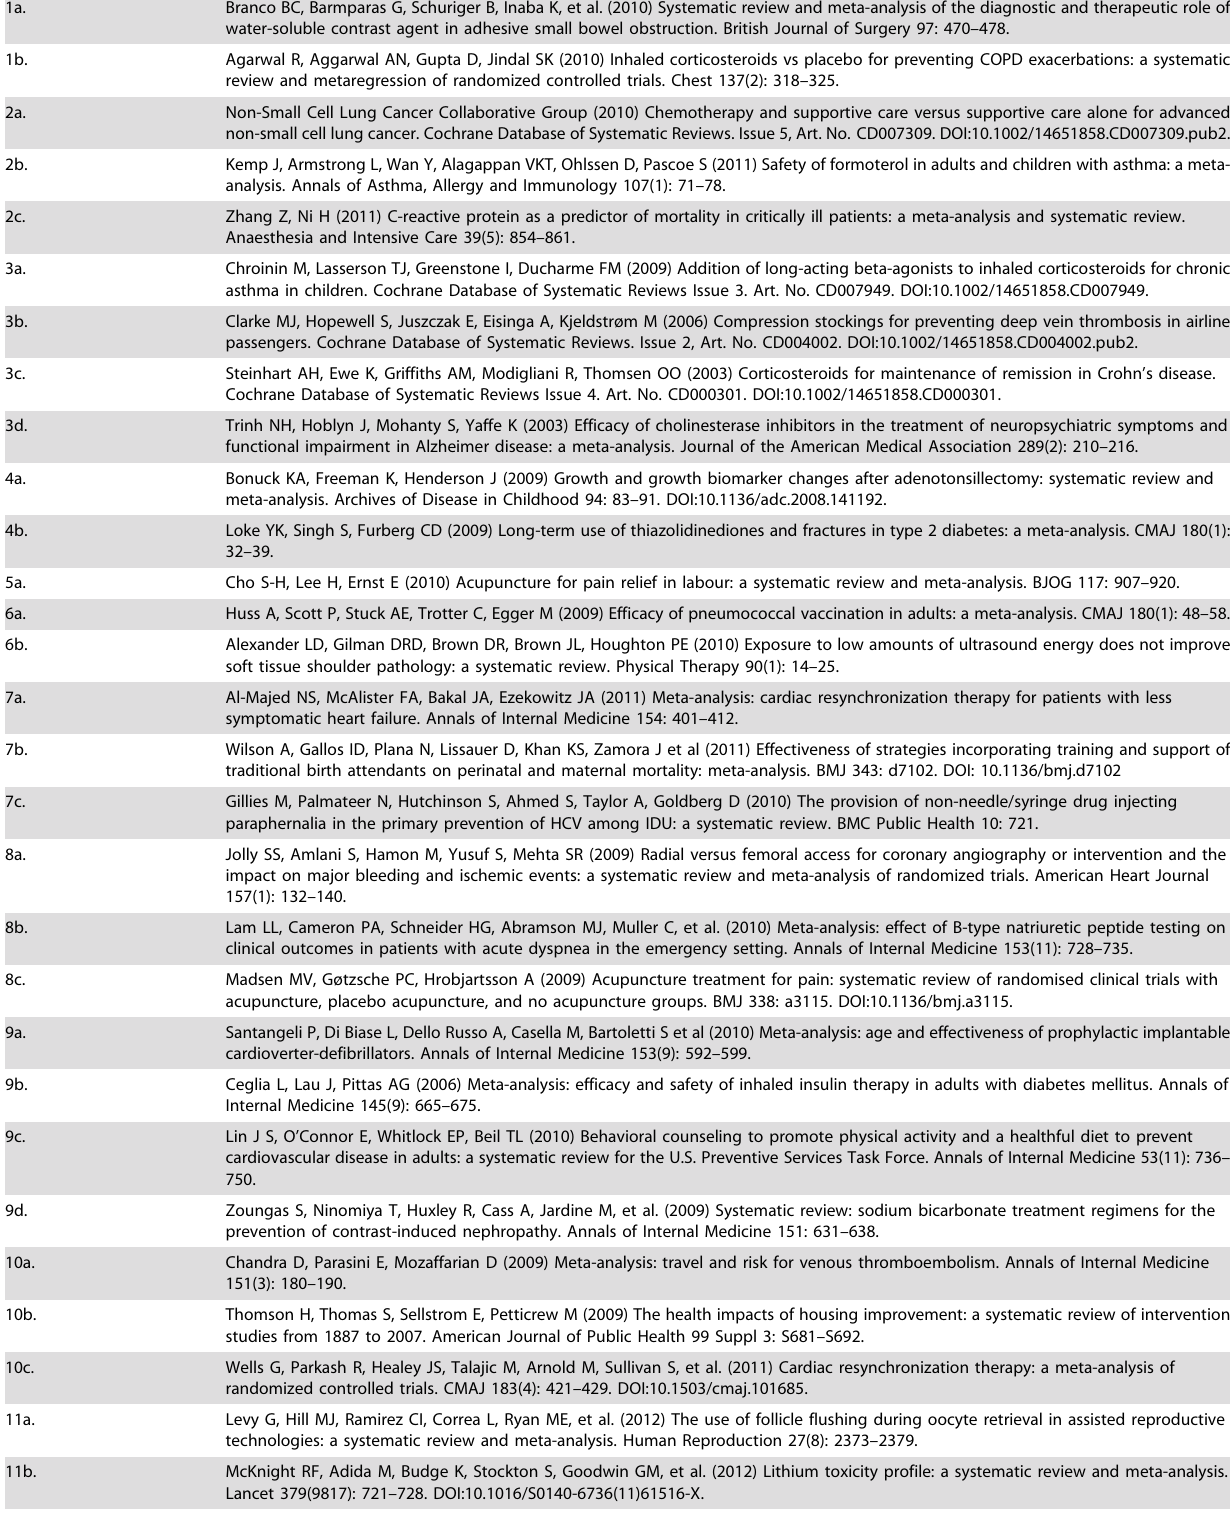
Table 2. List of references used as